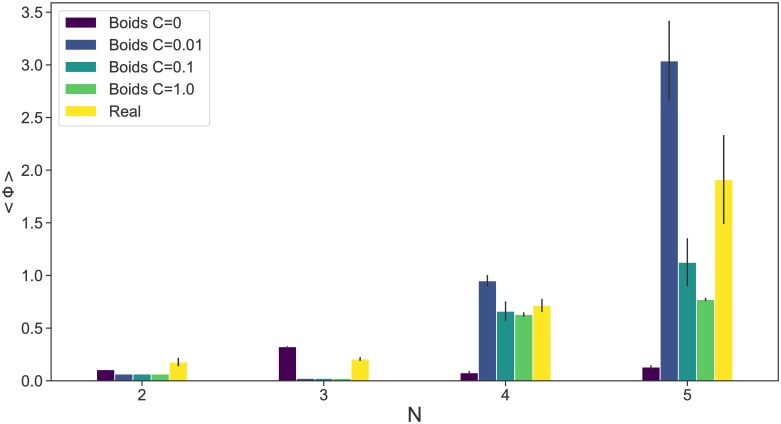
Comparison of the Φ values for certain parameter settings.The values of ΦBoids were calculated at the parameter configurations that maximise the real fish 〈Φ〉Real and averaged for 10 simulations. Error bars indicate the standard deviations.